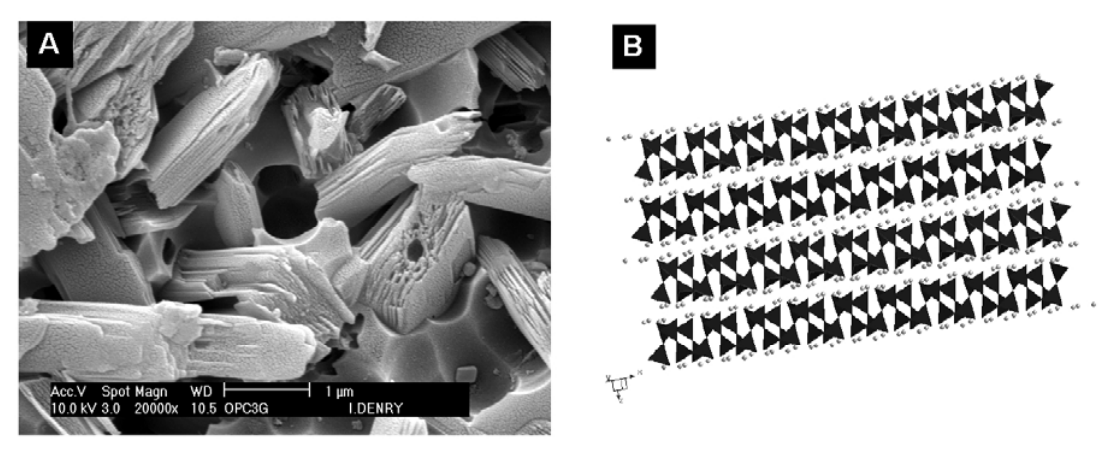
tetrahedra sharing corners, Li atoms in 4